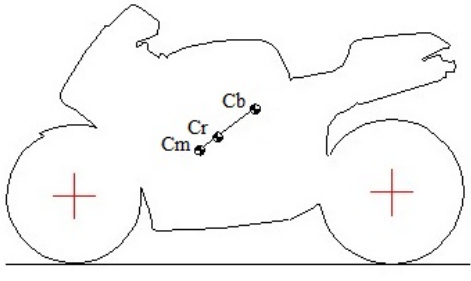
Figure 1. Centre of mass location: motorbike only (Cm), with rider in straight (Cr), and braking position (Cb).